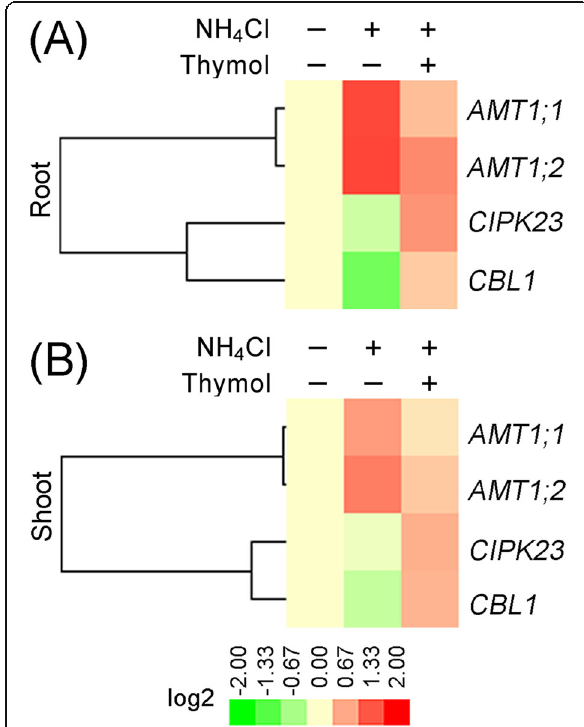
Fig. 5 Thymol modulated the expression of genes related to ammonium transportation in root ( a ) and shoot ( b ) of rice seedlings. Red and green indicate up-regulation and down-regulation,